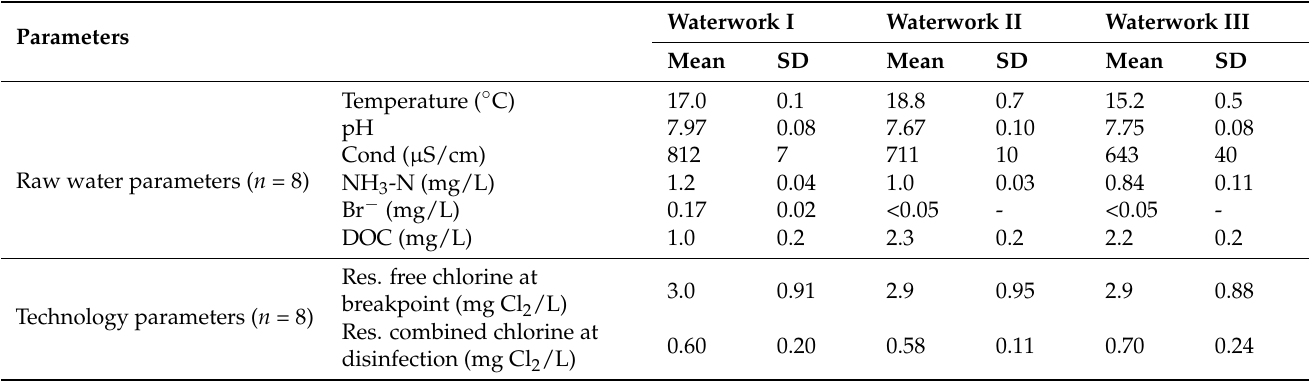
Table 2. The means and standard deviations (SDs) of raw water and technology parameters in the investigated waterworks